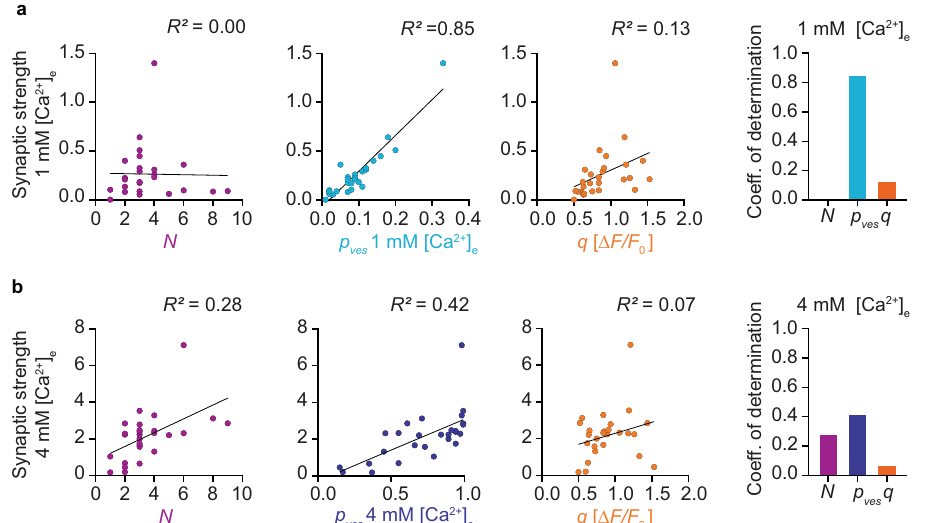
Fig.7|Quantalparametersandsynapticstrength.a Linearcorrelationsbetween theextractedquantalparameters N , p ves ,and q andthecalculatedsynapticstrength in 1mM [Ca 2+ ] e ( n =27boutons). b Linearcorrelations betweenquantalparameters